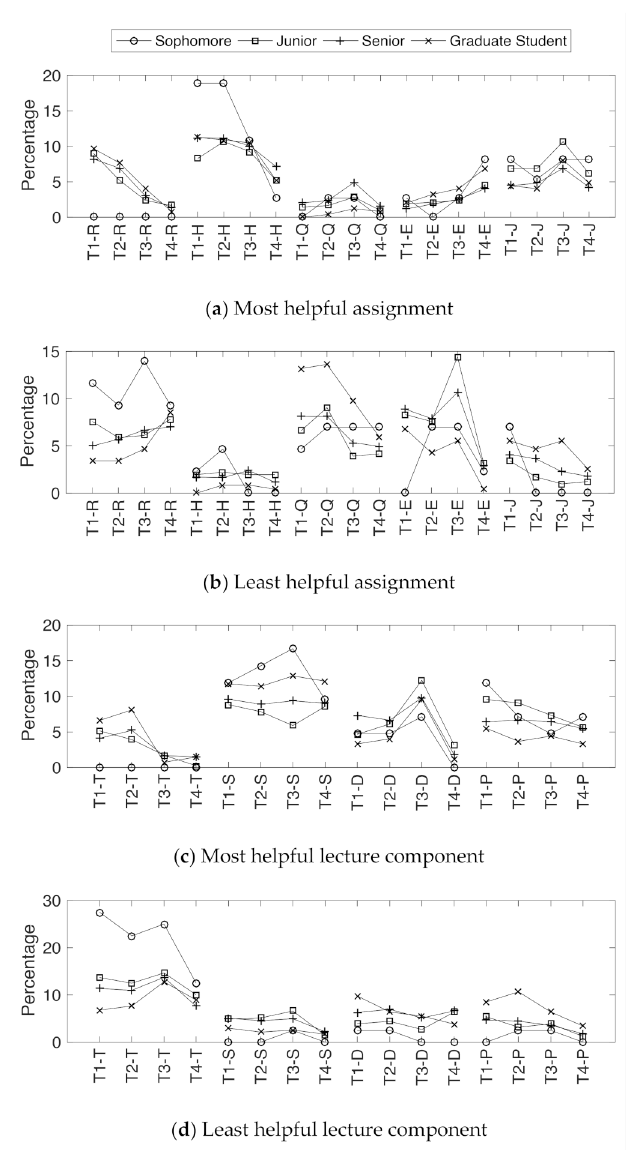
Figure 3. Comparison of model category signatures for students at different academic levels. T1–T4 = situational teaching categories; R = readings; H = homework; Q = quizzes; E = exams; J = projects; T = theory; S = problem-solving; D = discussion; P =